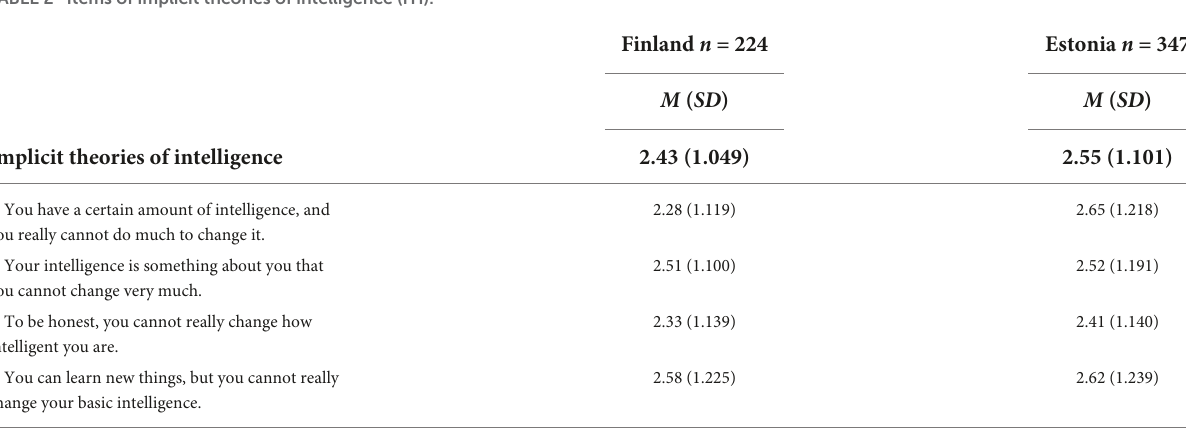
TABLE 2 Items of implicit theories of intelligence